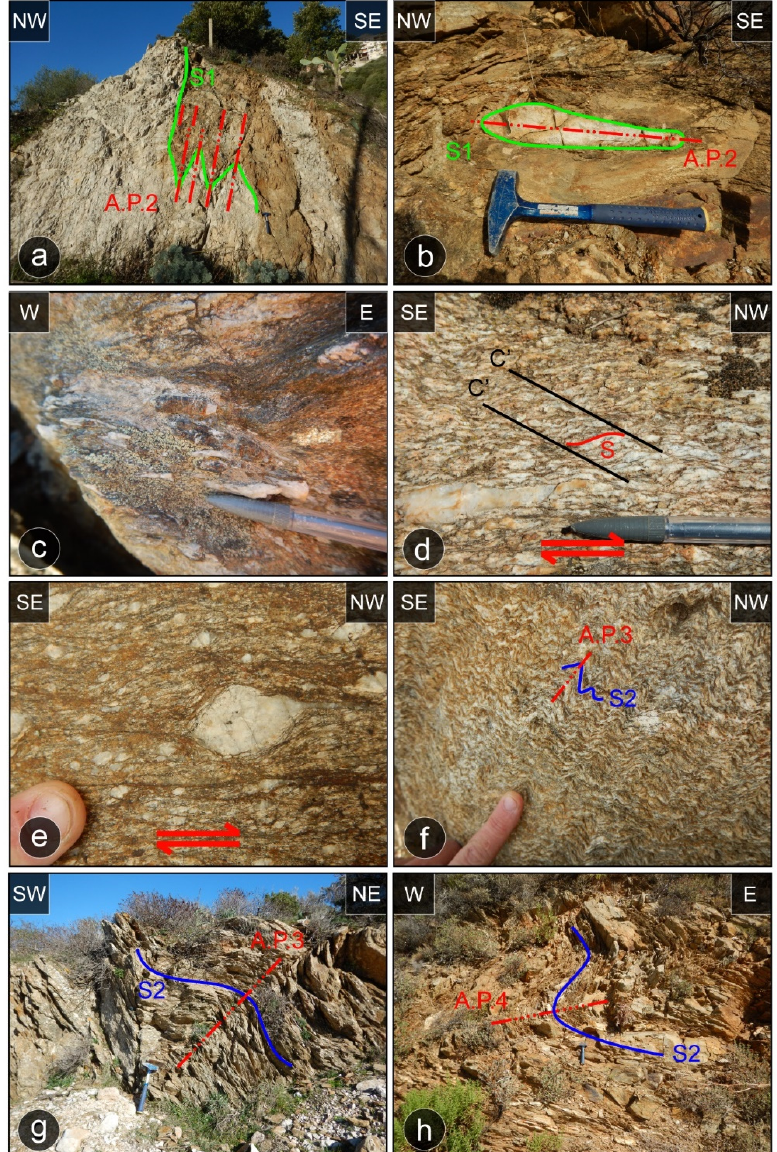
Figure 3. ( a ) F 2 cylindrical folds, in the granodioritic orthogneiss and leucogneiss, deforming an older relict foliation (S 1 ) (40 ◦ 35 (cid:48) 30.9 (cid:48)(cid:48) N–9 ◦ 31 (cid:48) 52.5 (cid:48)(cid:48) E); ( b ) F 2 non-cylindrical folds (sheath fold) deforming the older foliation (S 1 ) in the garnet-bearing micaschist (40 ◦ 38 (cid:48) 39 (cid:48)(cid:48) N–9 ◦ 38 (cid:48) 23 (cid:48)(cid:48) E); ( c ) L 2 sub-horizontal object lineation, defined by staurolite crystals, in staurolite-garnet-bearing micaschist (40 ◦ 36 (cid:48) 6 (cid:48)(cid:48) N–9 ◦ 34 (cid:48) 57 (cid:48)(cid:48) E); ( d ) mesoscopic aspect of D 2 deformation. C’–S fabric in granodioritic orthogneiss, pointing to a top-to-the NW sense of shear (40 ◦ 35 (cid:48) 45 (cid:48)(cid:48) N–9 ◦ 35 (cid:48) 29 (cid:48)(cid:48) E); ( e ) sheared augen gneiss with C–S fabric showing a dextral sense of shear (top-to-the NW). σ -type porphyroclast pointing a top-to-the NW sense of shear is also present (40 ◦ 35 (cid:48) 58 (cid:48)(cid:48) N–9 ◦ 33 (cid:48) 50 (cid:48)(cid:48) E); ( f ) kink folds (F 3 fold) in granodioritic orthogneiss a ff ecting the S 2 mylonitic foliation (40 ◦ 35 (cid:48) 29 (cid:48)(cid:48) N–9 ◦ 29 (cid:48) 56 (cid:48)(cid:48) E); ( g ) asymmetric F 3 folds in garnet-bearing micaschist that a ff ect the S 2 mylonitic foliation (40 ◦ 34 (cid:48) 58 (cid:48)(cid:48) N–9 ◦ 37 (cid:48) 44 (cid:48)(cid:48) E); ( h ) late open folds (F 4 ) with sub-horizontal axes and axial planes deforming the main foliation in staurolite-garnet-bearing micaschist (40 ◦ 36 (cid:48) 6 (cid:48)(cid:48) N–9 ◦ 35 (cid:48) 2 (cid:48)(cid:48)